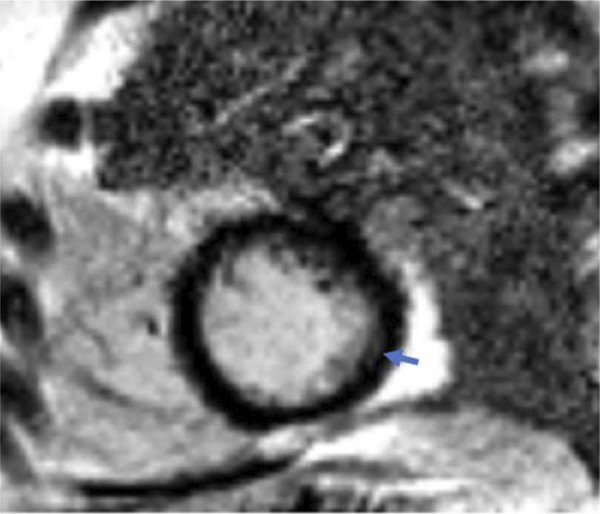
–
Short-axis delayed contrast-enhanced PSIR image represents sub-endocardial enhancement areas, mostly in the inferorolateral left ventricular wall. Scar tissue spanning in nearly 25-50% of wall thickness.